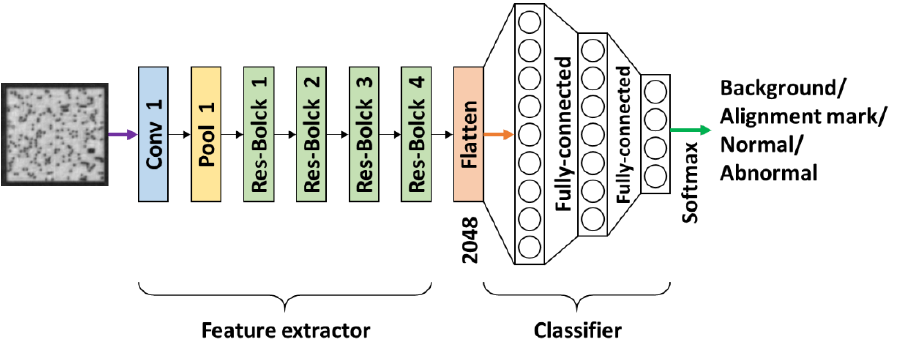
Figure 12. Deep convolutional neural network (CNN) for die pattern classification.